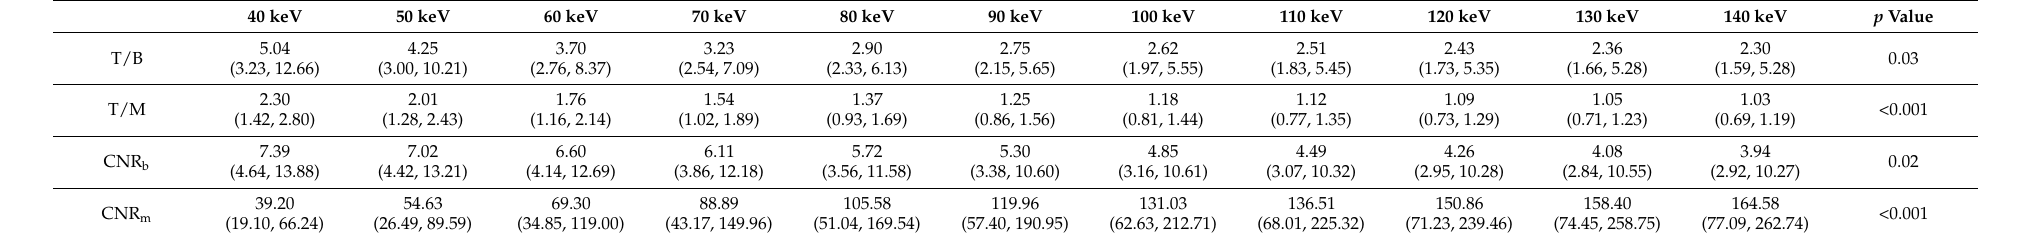
Table 1. Values of the tumor-to-breast mammary gland ratio (T/B), tumor-to-muscle ratio (T/M), contrast-to-noise ratio of breast tumor (CNR b ), and contrast-to-noise ratio of metastasized tumor (CNR m ) for each monochromatic spectral image. The data are shown as the median (minimum value, maximum value). 40 keV 50 keV 60